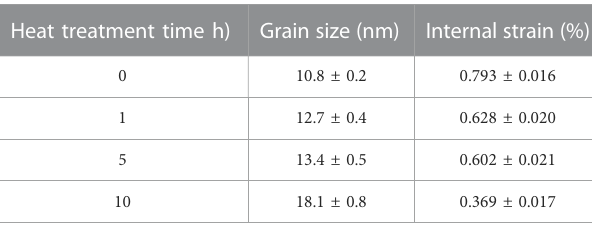
TABLE 1 Grain size and internal strain of FeCoCr powders after heat treatment at 400 °